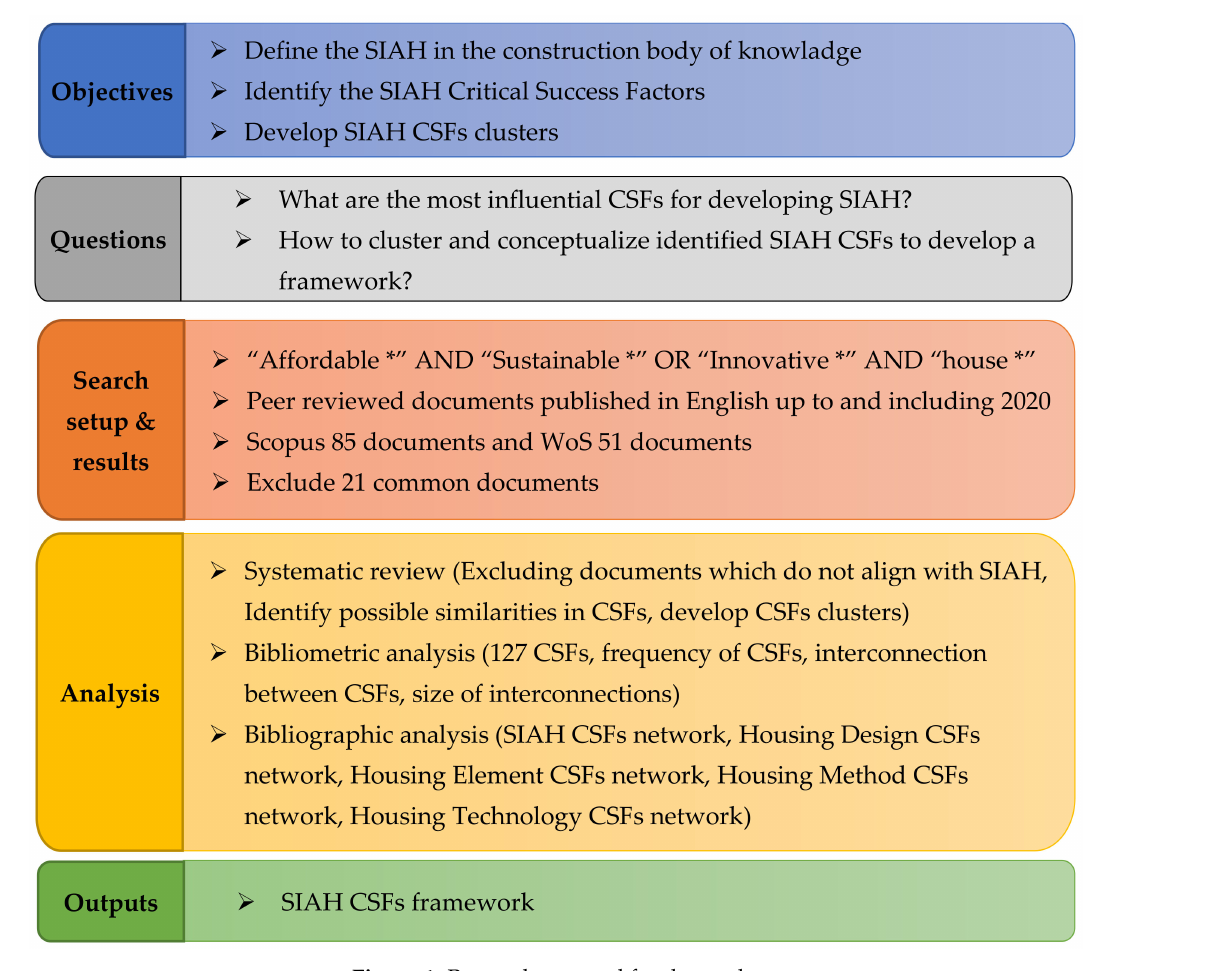
Figure 1. Research protocol for the